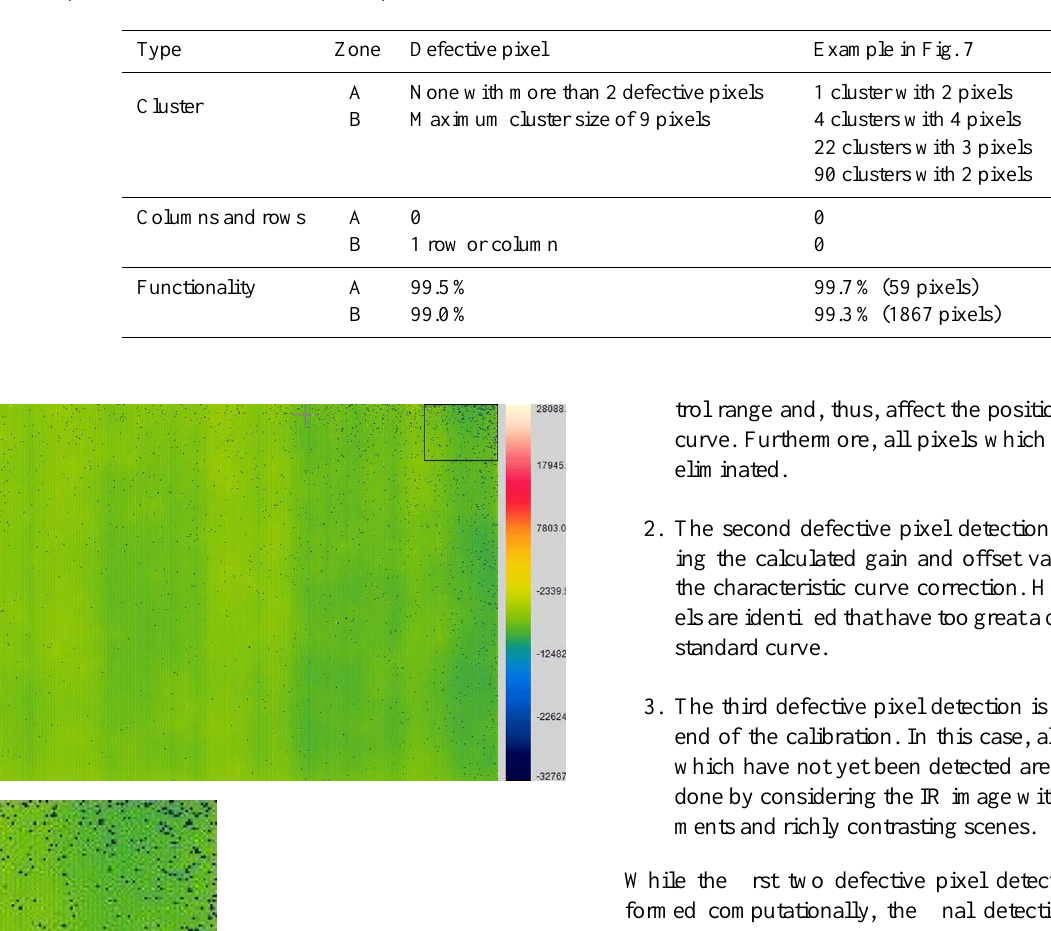
Table 1. Specification of allowable defective pixels.